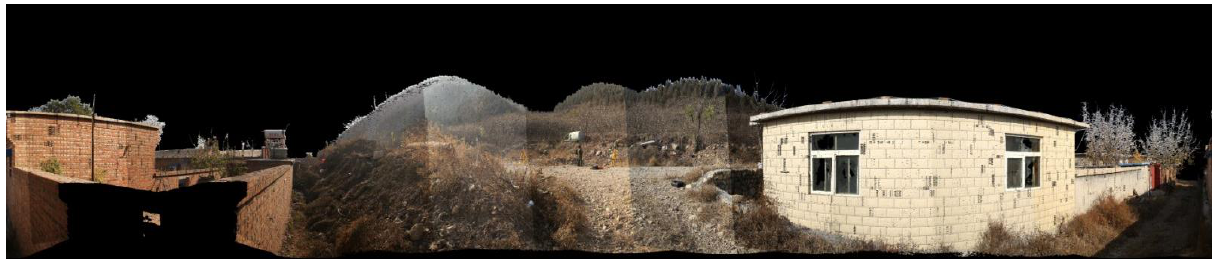
Figure 4. Registration of LiDAR point cloud and sequence